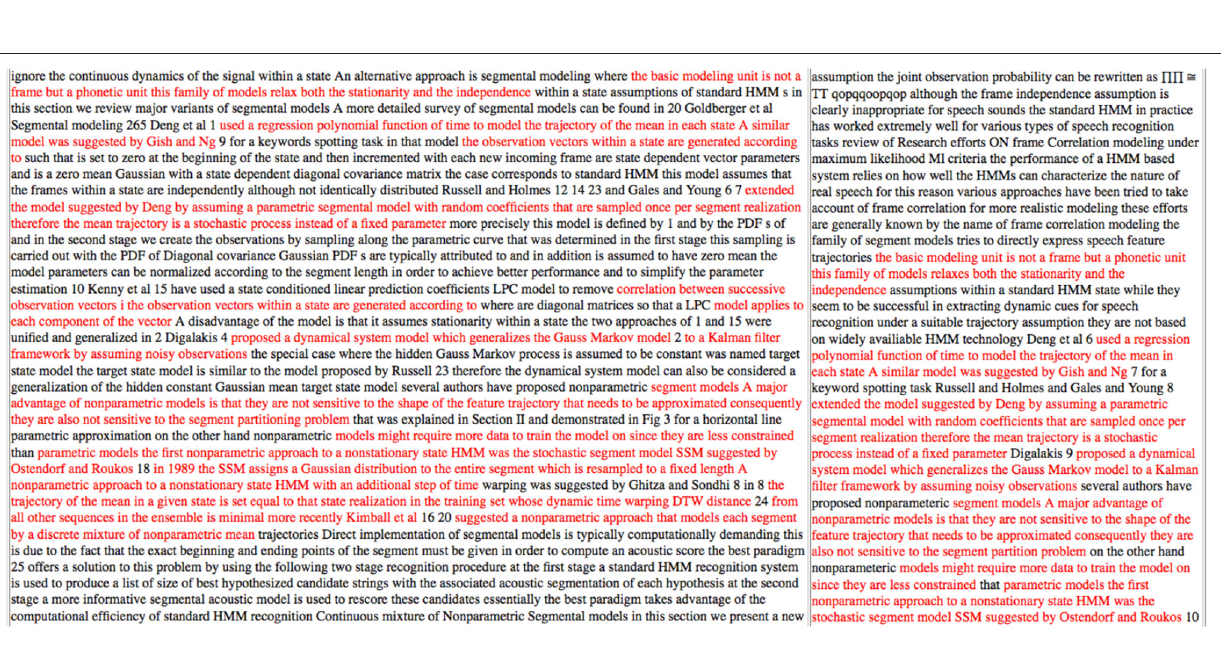
in the forward and backward directions (using sources are on the X axis, while used sources are on the Y axis. The total of used and using papers, and the difference between those totals, are also presented, while the 5 top using or used sources are